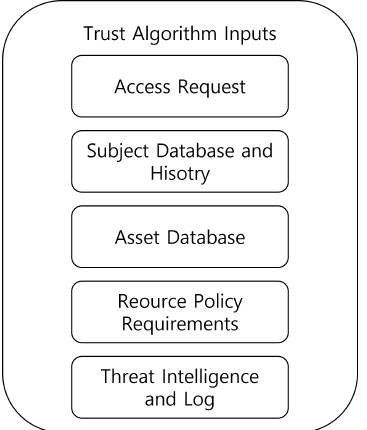
Figure 2. Trust Algorithm in